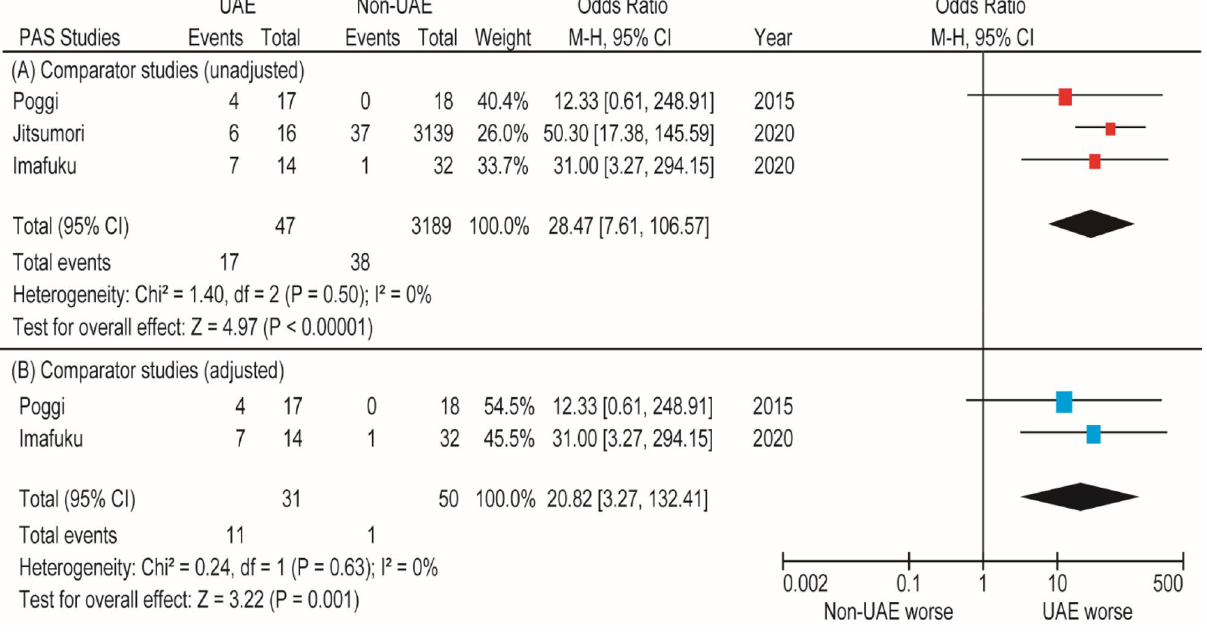
Figure 2. Results of the meta-analysis of the effect of prior UAE on the prevalence of PAS. The pooled odds ratios of ( A ) PAS and ( B ) PAS with previous PPH for women who did and did not undergo prior UAE. Some values listed might be slightly different from the original values because the calculation was performed using Revman ver. 5.4.1. PAS placenta accreta spectrum, UAE uterine artery embolization, CI confidence interval, df degrees of freedom.